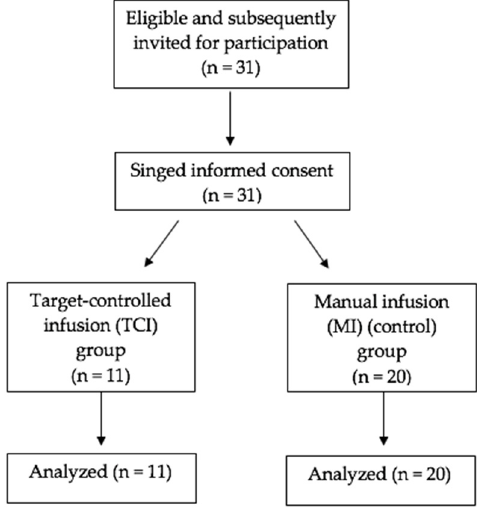
Figure 1. Flow chart for patient enrolment.